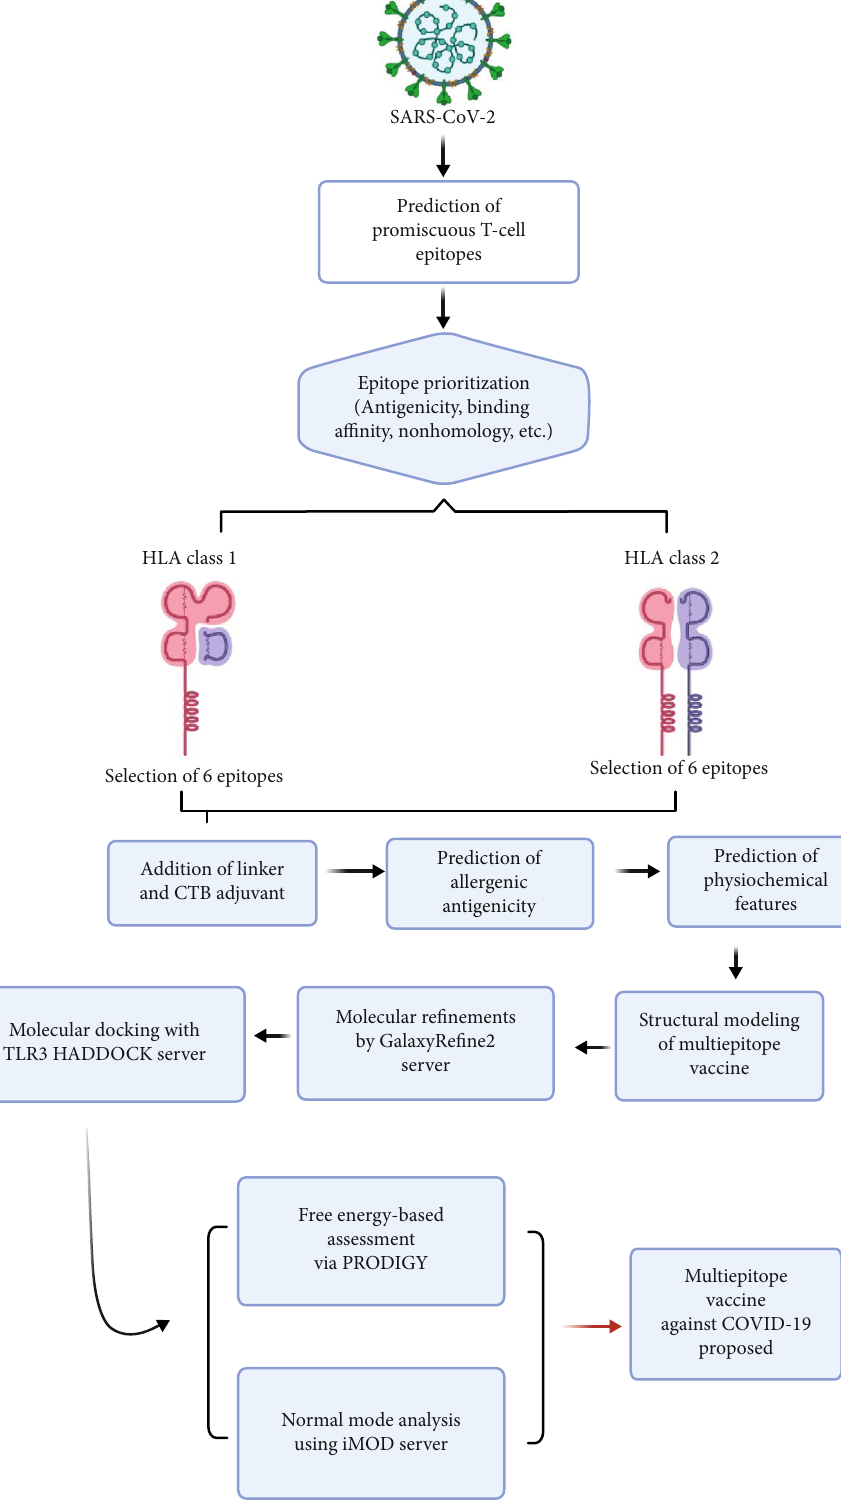
Figure 1: Here, the overall design of our study is shown. The sequence of SARS-CoV-2 spike protein was subjected to in silico epitope prediction and prioritization steps to select promiscuous T-cell epitopes. These epitopes were linked together to construct a multiepitope vaccine which was subjected to molecular docking analysis with TLR3. Based on these results, a multiepitope vaccine was proposed against